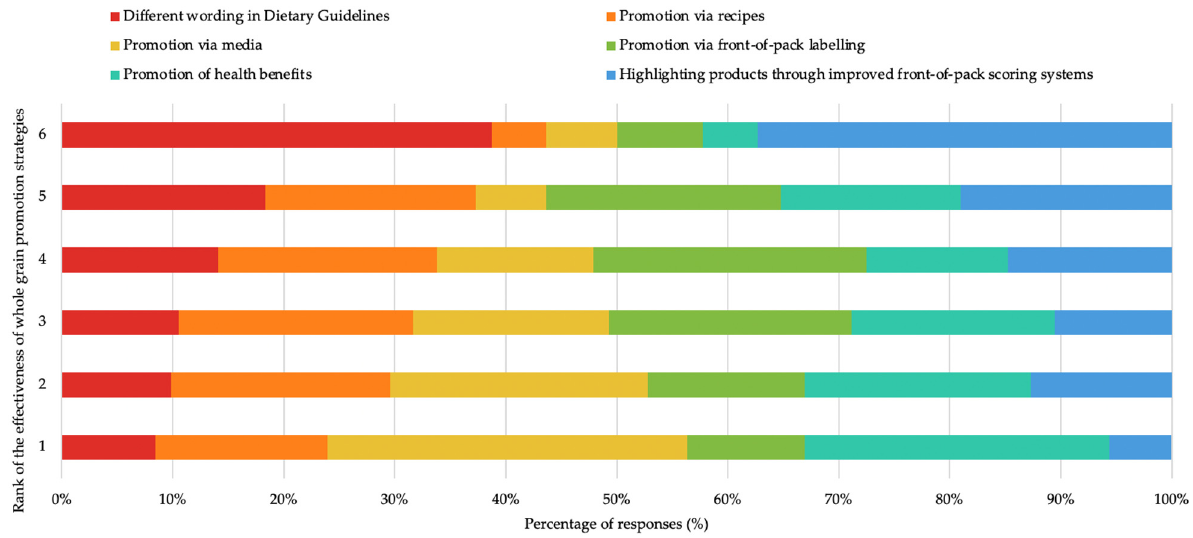
Figure 2. Dietitians’ responses ranking the effectiveness of previously used whole-grain-promotion strategies on a scale of 1–6 (1 being most effective, 6 being least effective).